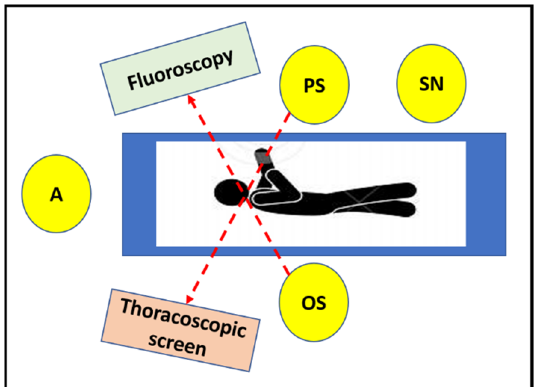
Figure 2. Position of the surgical team (scheme): the pediatric surgeon stands in front of the patient, with the thoracoscopic screen on the opposite side or at the bottom of the table, while the orthopedic surgeon stands on the back of the patient (in front of the spine) looking at the monitor of C-arm fluoroscopy. The scrub nurse stands on the left of the pediatric surgeon. (A = anesthetist, PS = pediatric surgeon, OS = orthopedic surgeon, SN = scrub nurse).